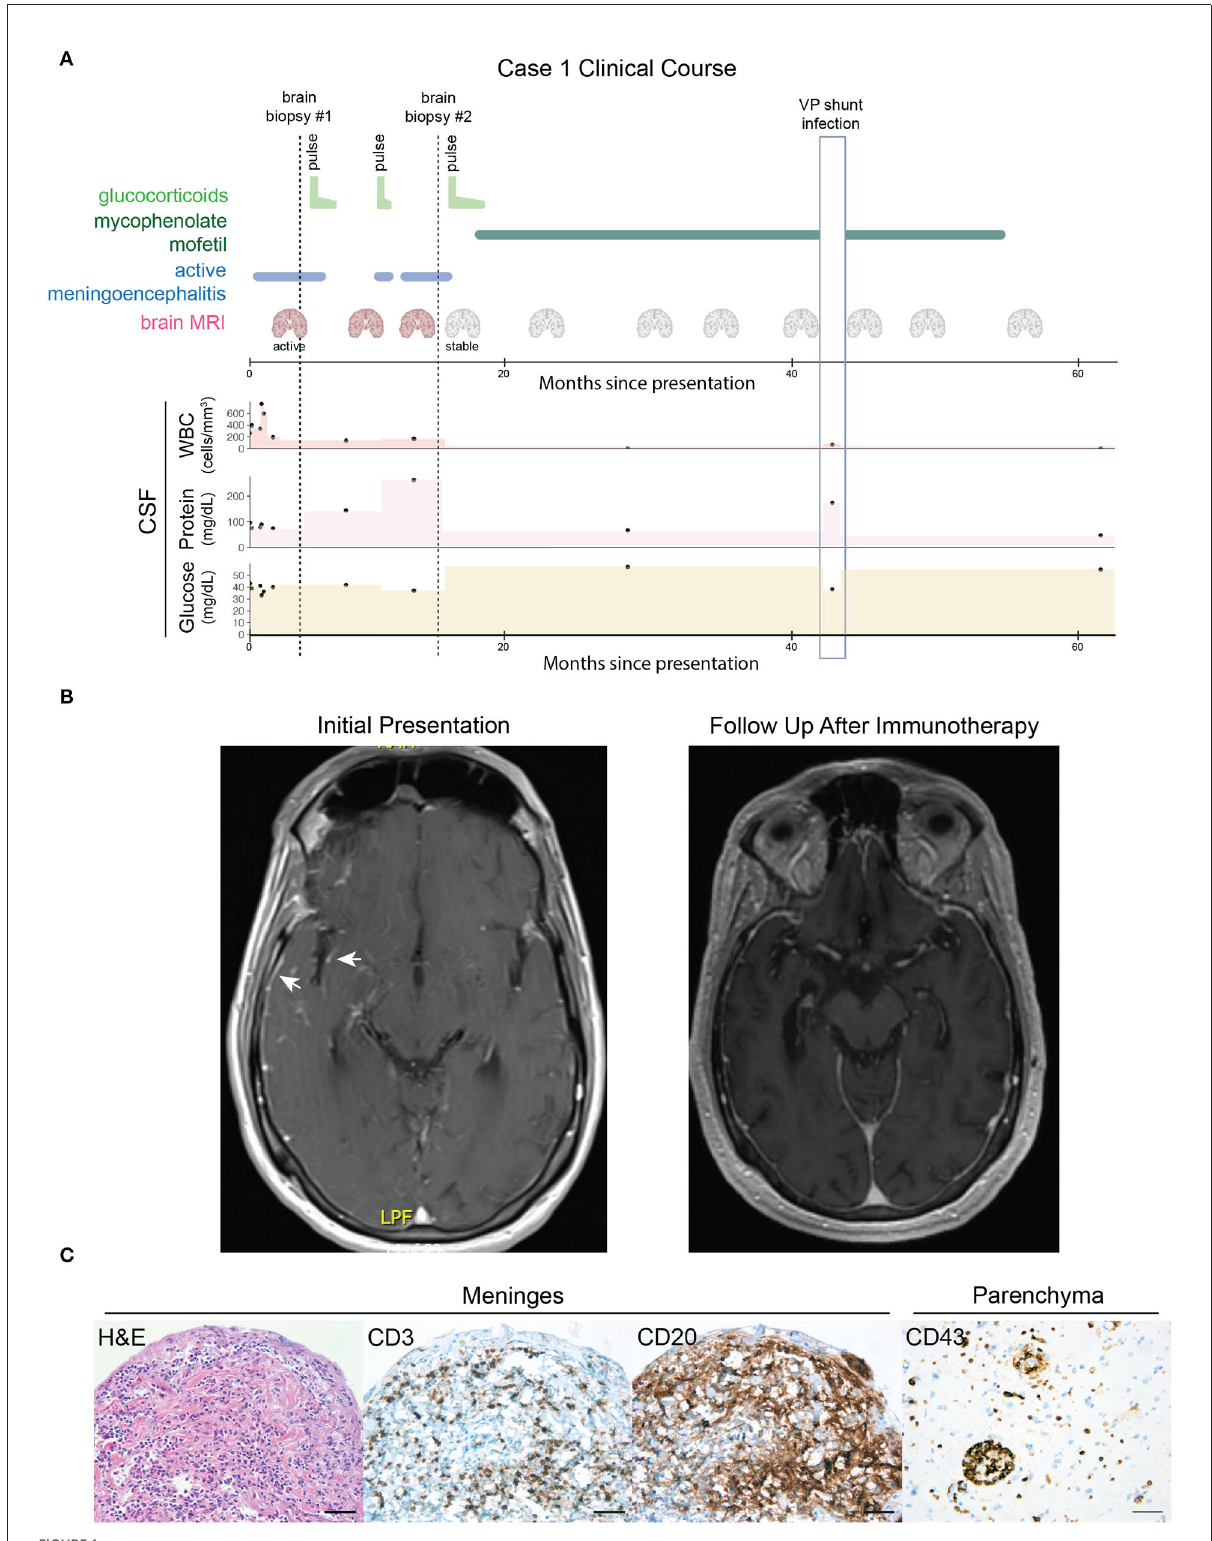
FIGURE1 Case 1, course of illness and clinical studies. (A) A graphical time course of events. Brain biopsies are indicated by vertical dotted lines. Periods of glucocorticoid and mycophenolate mofetil immunosuppressive therapy are indicated by light and dark green lines, respectively.